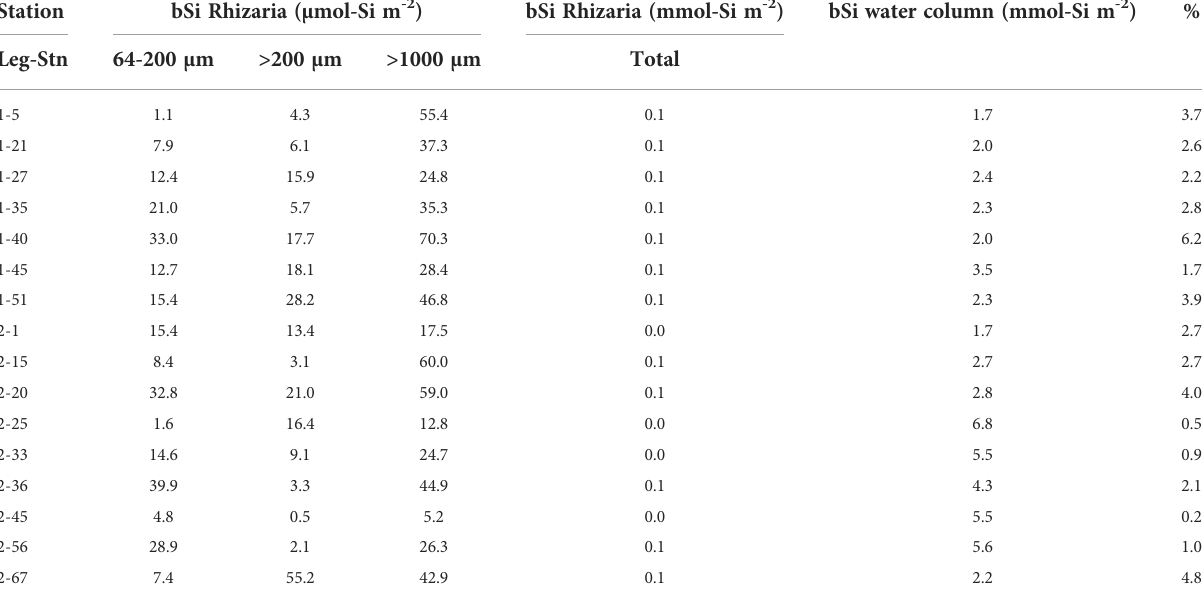
TABLE 4 Biogenic silica integrated over the 0 – 500 m layer for Rhizaria collected using three different devices corresponding to different size ranges.